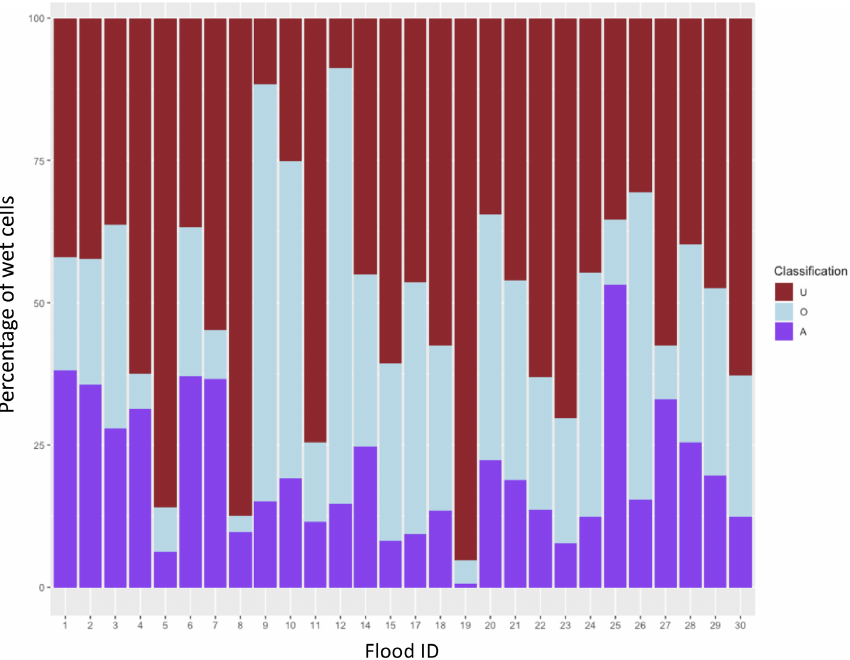
Figure 3. Stacked bar plot of the accuracy, over, and under prediction (AOU) metrics for each floodplain case study. Each bar represents 100% of the inundated cells in the intersected simulation and observed events.